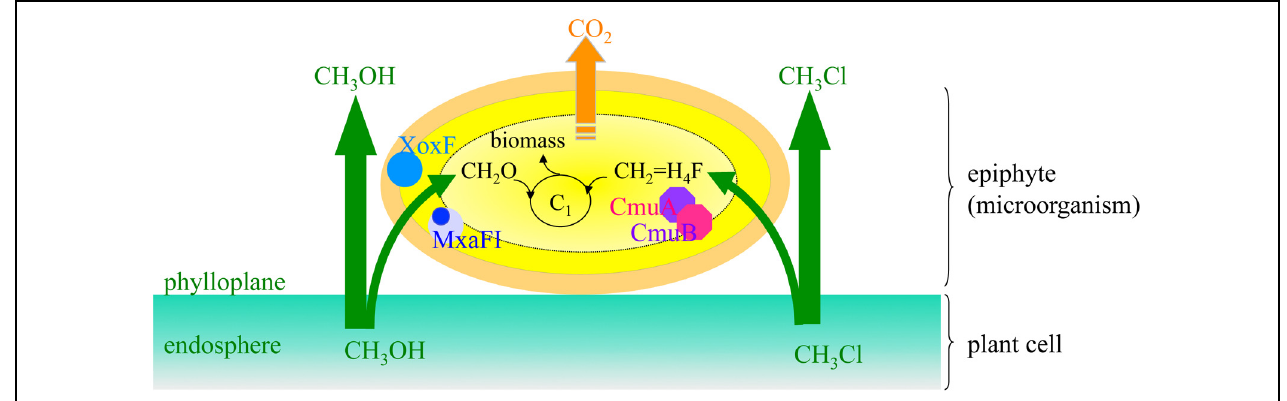
FIGURE 4 | Biocapture of plant C1 VOCs by methylotrophs of the phyllosphere. Key enzymes in methanol oxidation imply the MxaFI methanol dehydrogenase subunits (Chistoserdova et al., 2009), and a methanol-dehydrogenase-like protein XoxF whose mutation renders the bacteria less competitive than the wild-type Methylobacterium extorquens AM1 during